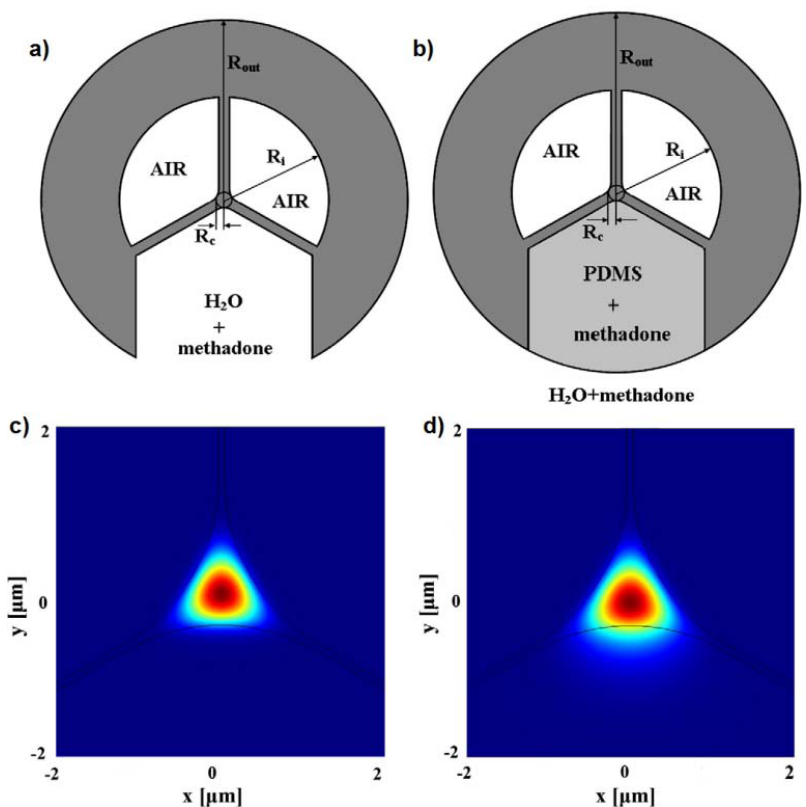
Figure 18. Sketch of the ( a ) exposed-core fiber; and ( b ) exposed-core fiber with polydimethylsiloxane PDMS coating. Simulated transverse electric field norm of the HE y-polarized guided mode at the wavelength λ = 292 nm for ( c ) exposed-core fiber; and ( d ) exposed-core fiber with PDMS coating